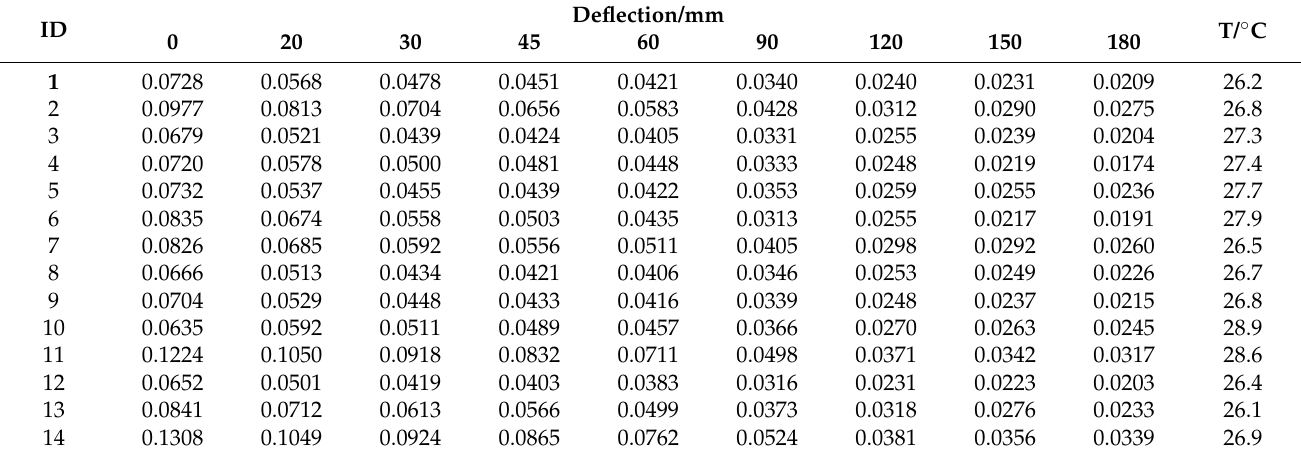
Table 6. Measured deflection and temperature information.